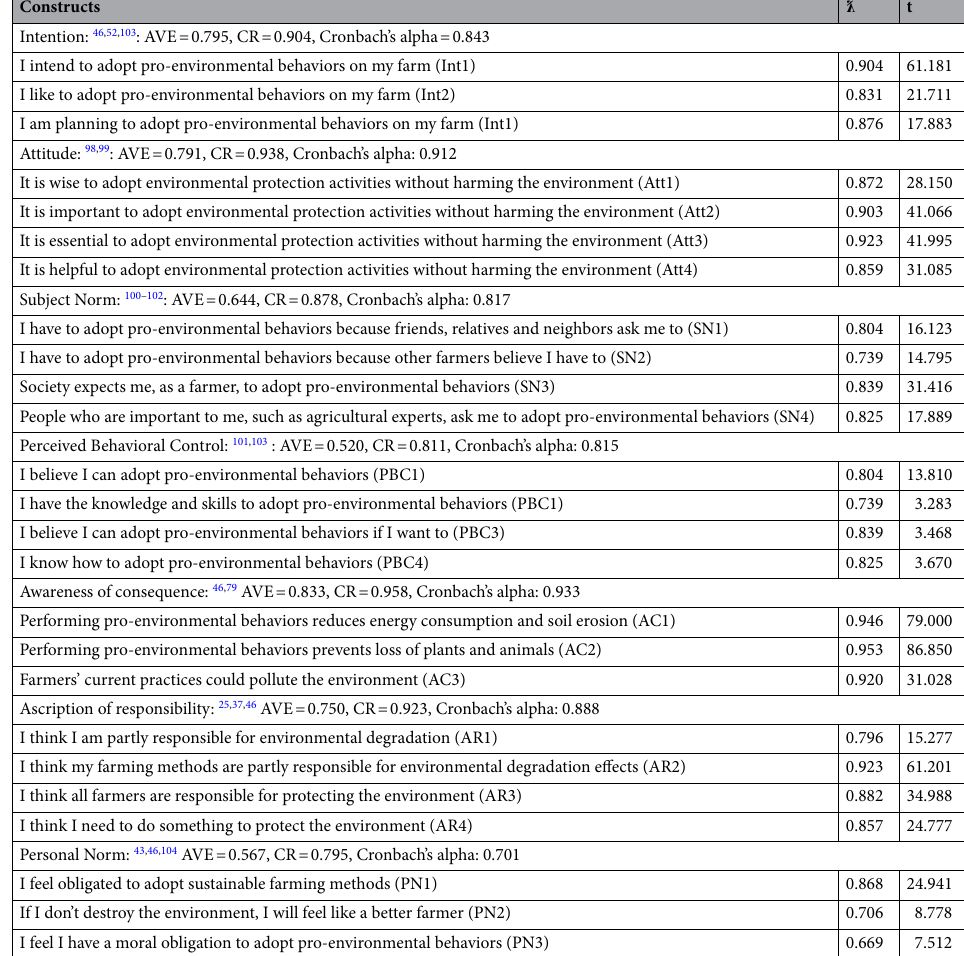
Table 4. Results of confirmatory factor analysis for the measurement model.